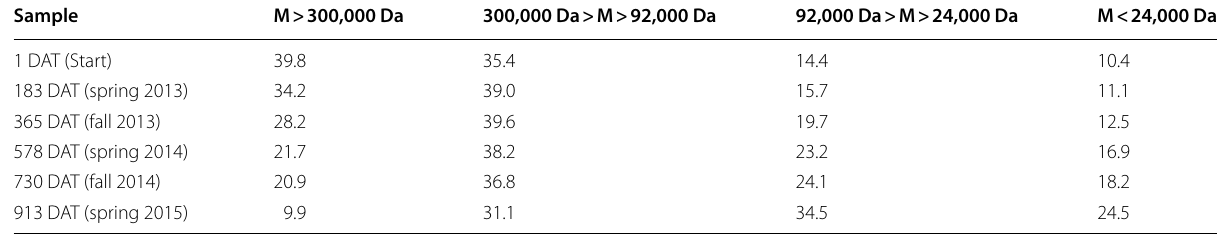
Data in % of total signal area